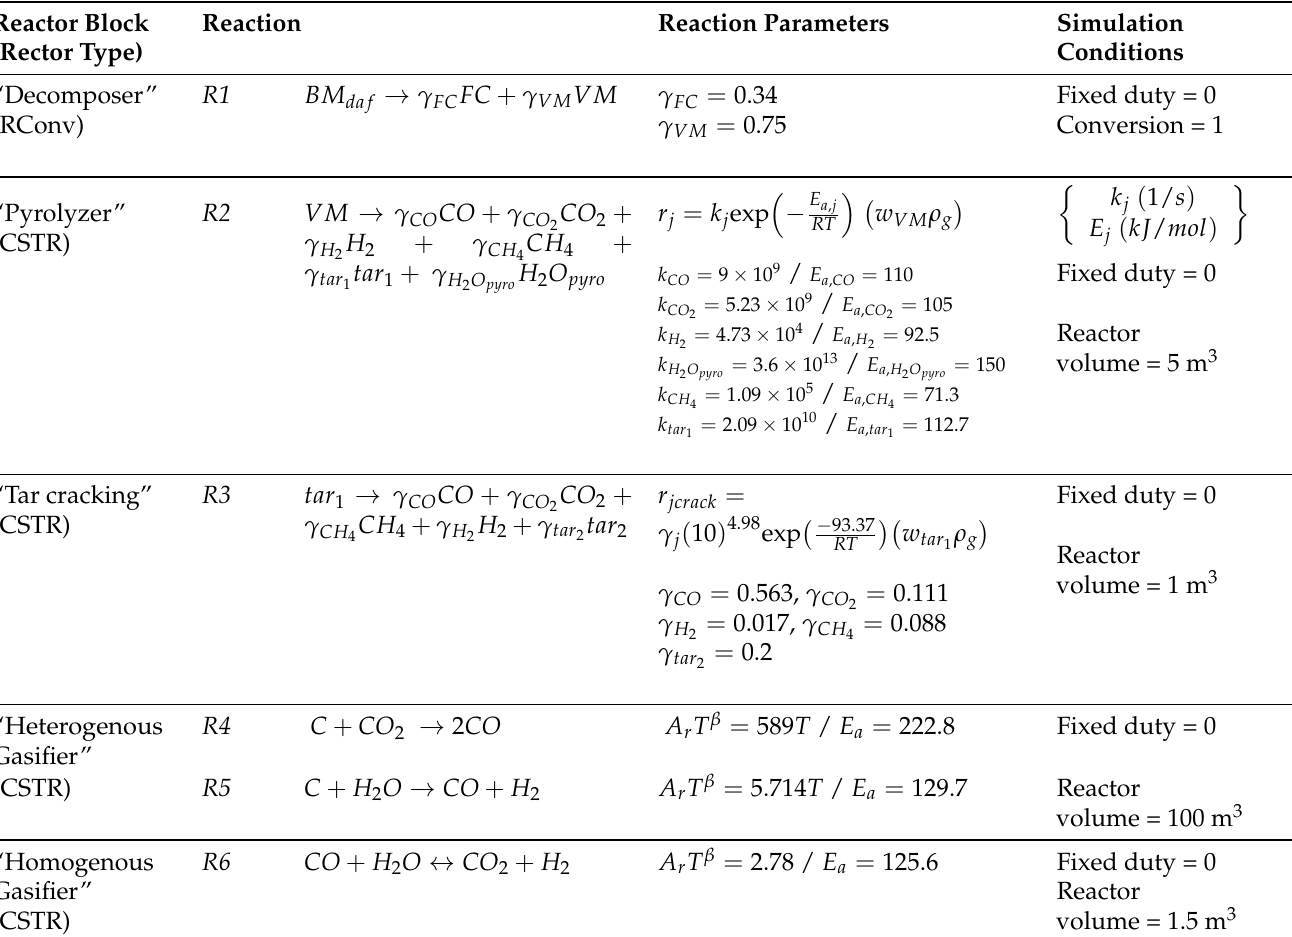
Table 3. Reaction conditions for the model KinetM . The reaction parameters are taken from the literature; i.e., R1 is taken from [44], R2 and R3 from [26], and R4 to R6 from [16]. T has a Kelvin